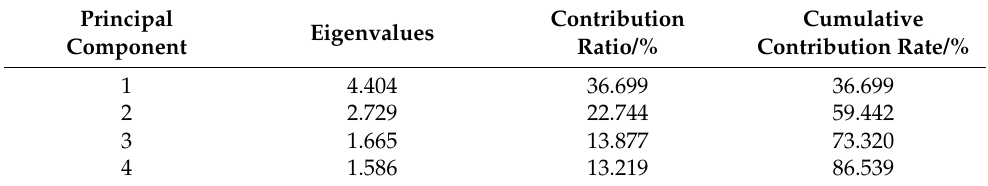
Table 6. The eigenvalues, contribution ratio, and cumulative contribution ratio of the principal components under mild drought stress.